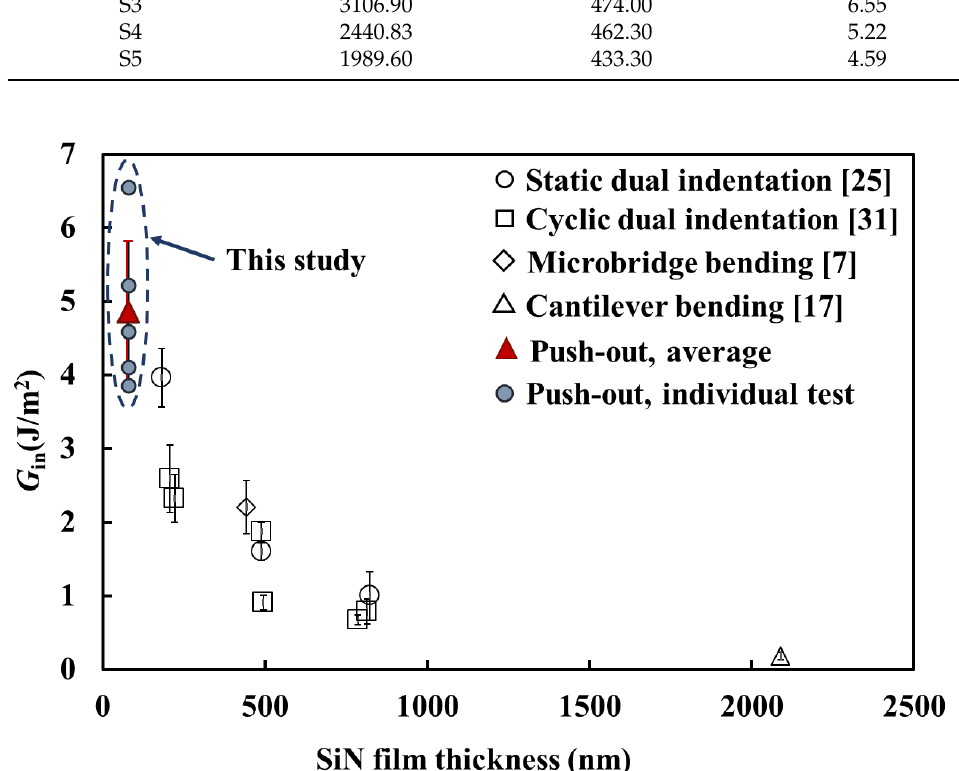
Figure 8. The G in values of a variety of SiN/GaAs interface measured using different micro-mechanical testing techniques, plotted against the thickness of SiN film.